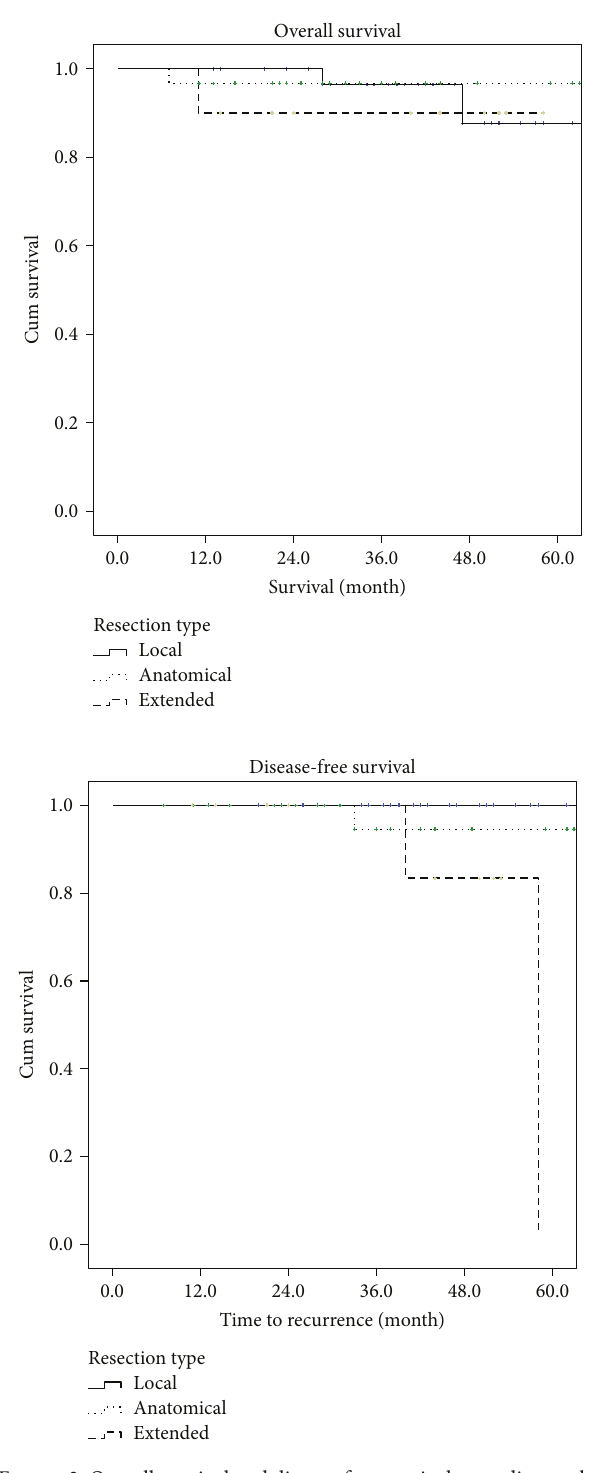
Figure 2: Overall survival and disease-free survival according to the surgery type.